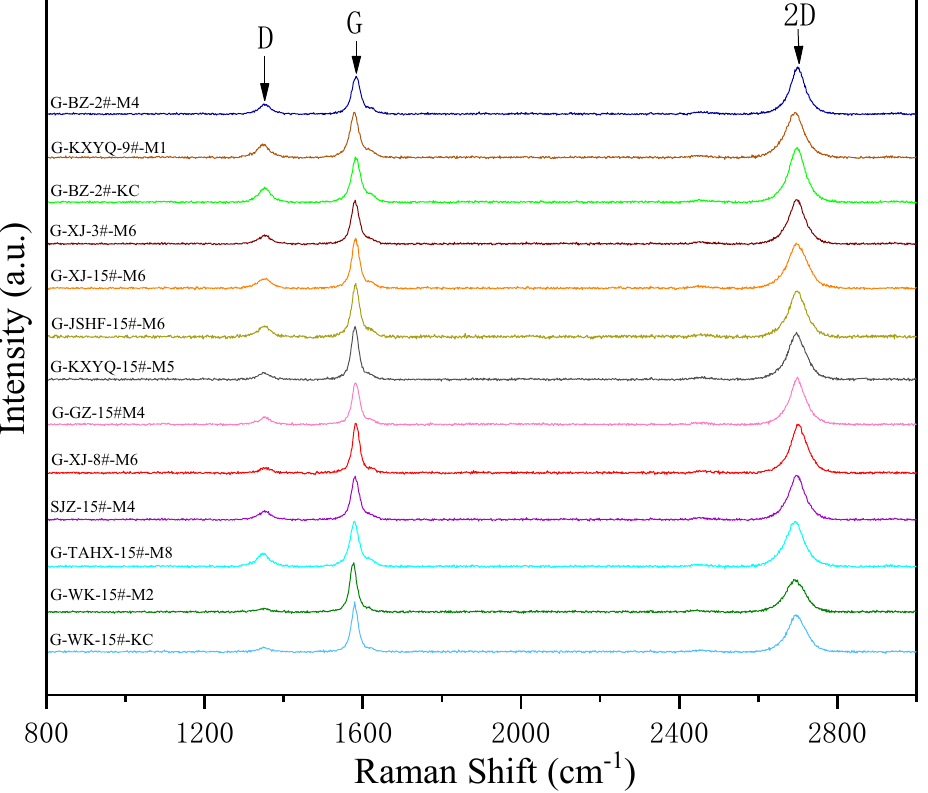
Figure 10. Scatter diagram of I D /I G .